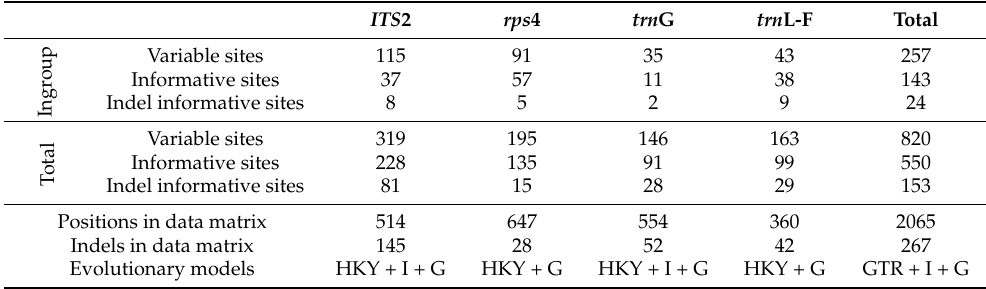
Figure 1. Consensus phylogenetic tree obtained from the Bayesian Inference analysis with the combined matrix ( ITS 2, rps 4, trn G, trn L-F and indels coded). Posterior probabilities greater than 0.8 for BI and Bootstrap values greater than 70% for ML are included. Sequences information is available in Table S1. The locality where the samples were collected is indicated for Codonoblepharonteae: Australia (AUS), California (CA), France (FR), New Zealand (NZ) and Spain (SP). Table 2. Number of variable and informative positions for the concatenated matrix and for the four analysed